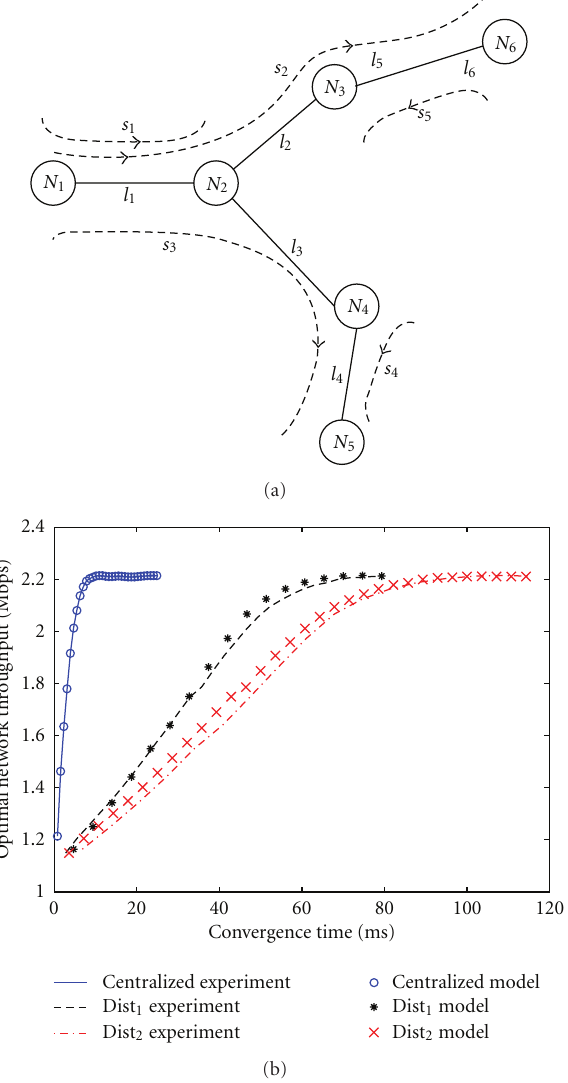
Figure 1: (a) Example network with each node equipped with TI’s DSP (TMS320C6713) running at 225 MHz and MicroLinear’s ML2722 RF transceiver; (b) Convergence performance comparison of overhead model with experimental realization for centralized and distributed implementations.